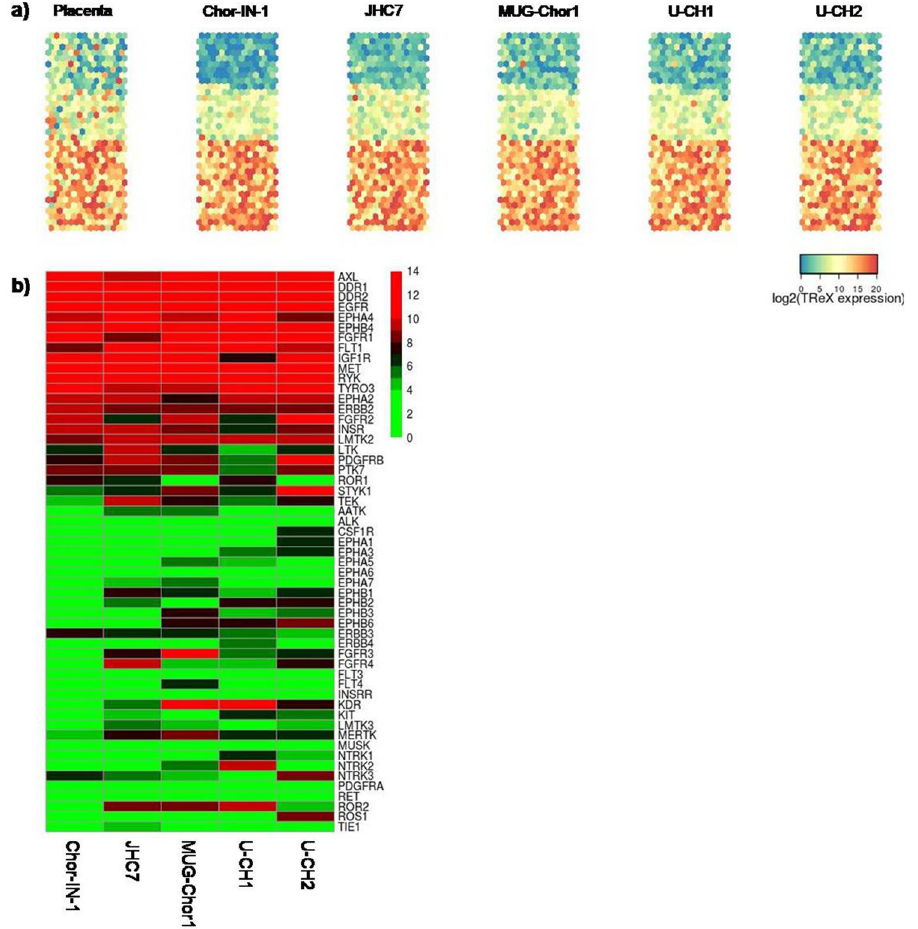
Figure 6. Kinase gene expression levels in chordoma cell lines. ( a ) Kohonen maps reporting gene expression levels of 487 kinases in the different chordoma cell lines. Placenta was used as control sample. Each dot represents an individual kinase whose position is kept constant in the map. Colormap gradient from blue to red reflects increasing gene expression level, expressed in log2 scale. ( b ) Heatmap reporting gene expression levels of RTKs (log2 scale) sorted from high to low levels. Colours reflect gene expression levels according to reported